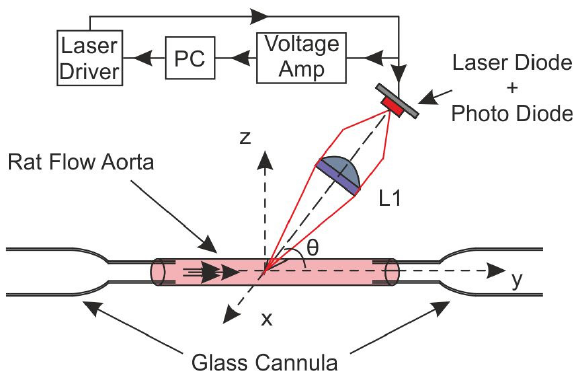
Figure 20. OFI pressure myograph sensor